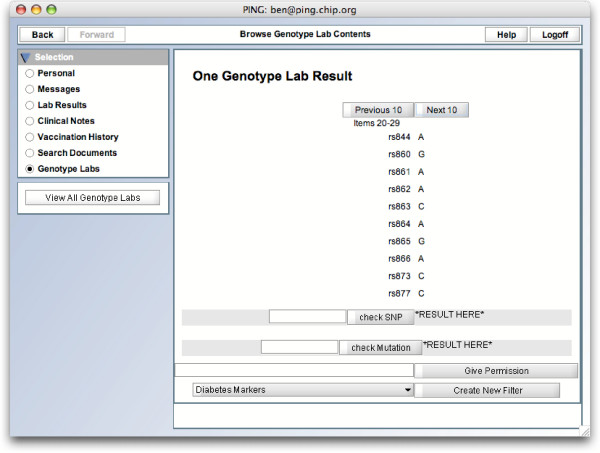
GenePING single genotype lab view. A patient's view of one of his genotype datasets. Note the interface that allows datapoints to be downloaded in batches, or individually when queried.